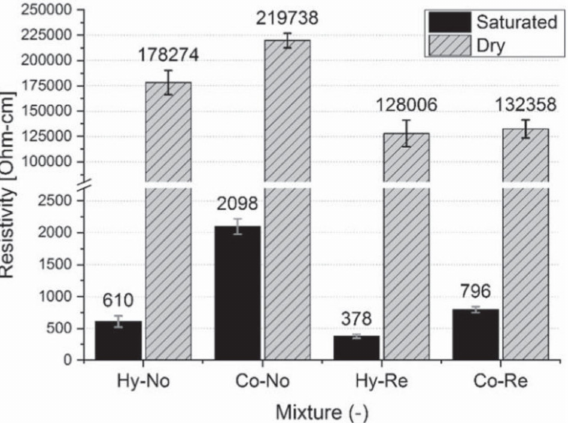
Figure 13. Resistivity of saturated and dry specimens. Reproduced with permission from [65], IOP Publishing Ltd.,